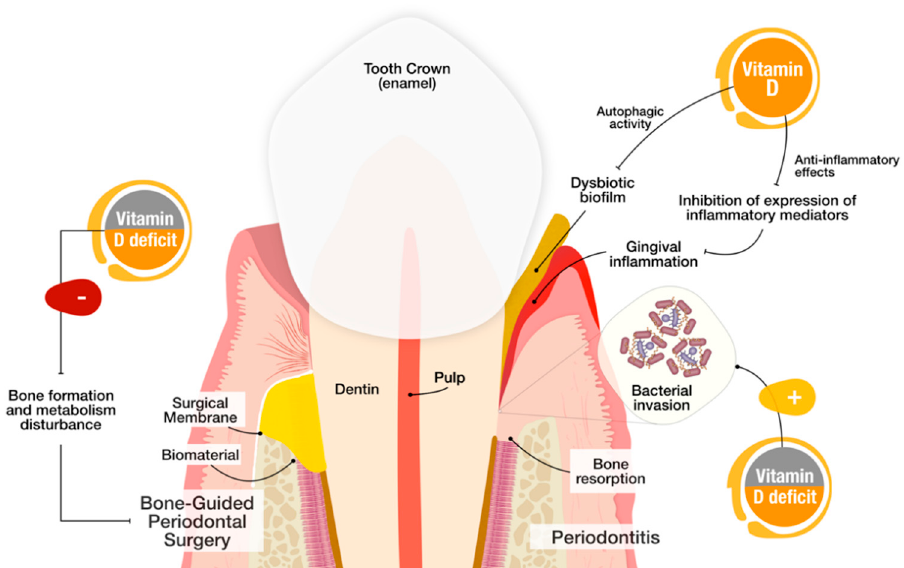
Figure 3. Suggested mechanisms of Vitamin D and Vitamin D deficiency (VDD) impact on periodontitis and periodontal regenerative surgery. ( Left ) Baseline VDD patients who undergo periodontal surgeries may be more prone to treatment failure due to the disturbance of bone formation and metabolism. ( Right ) In periodontitis, Vitamin D may promote P. gingivalis autophagy and anti-inflammatory e ff ects via inhibition of expression of inflammatory mediators, decreasing gingival